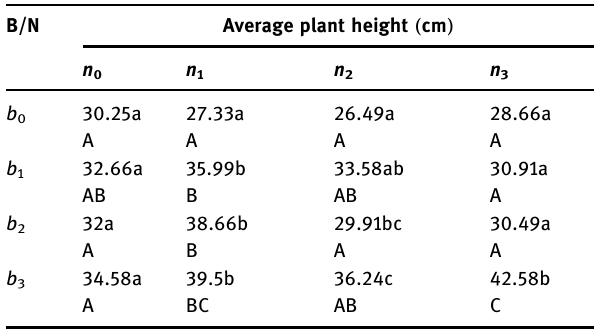
Table 1: Fermented compost and N - fertilizer on the plant height of the purple eggplant Treatment